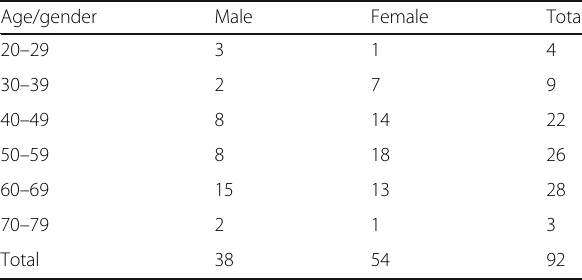
Table 1 Age and gender distributions ( n = 92)